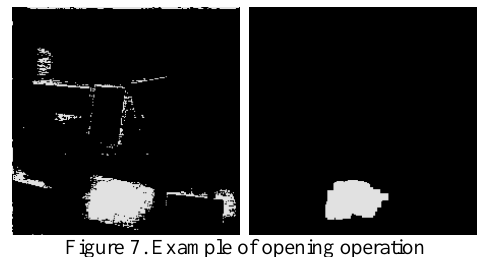
Figure 7. Example of opening operation (left: before opening, right: after opening)